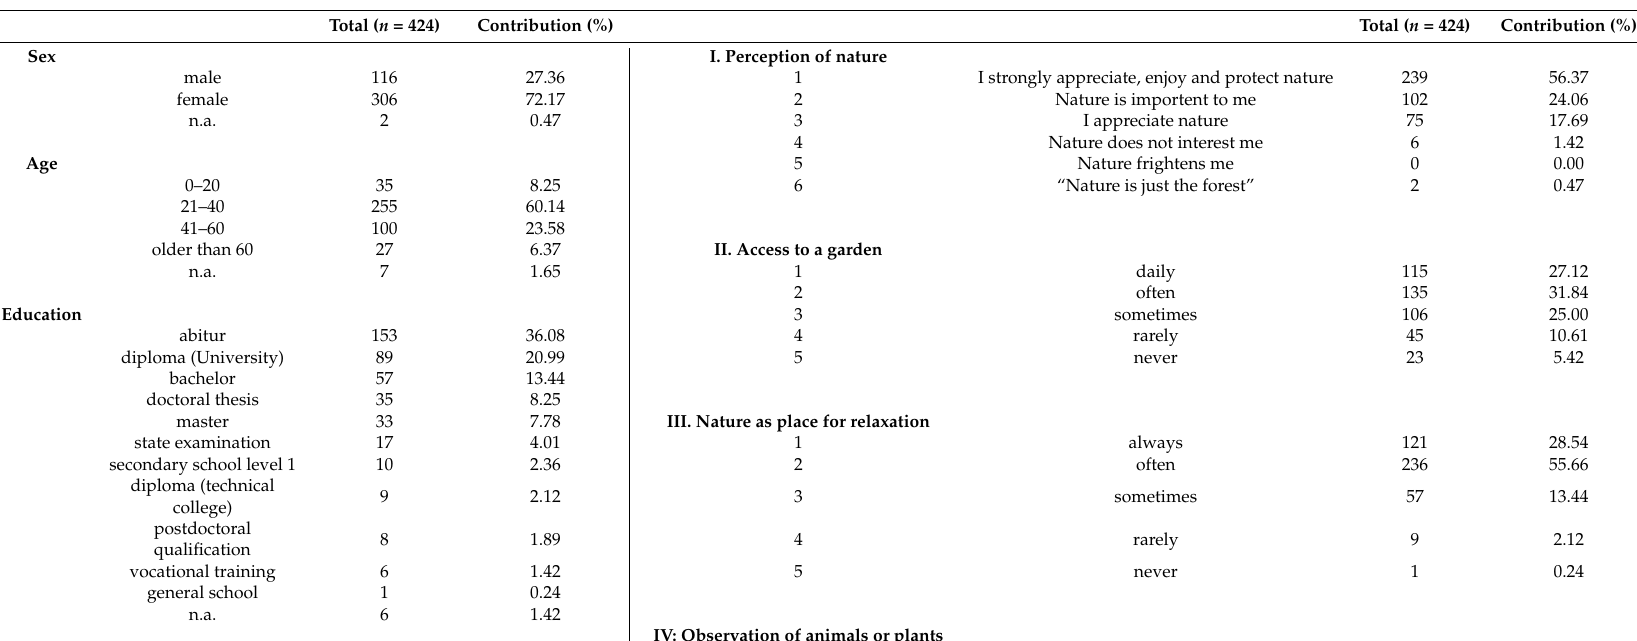
Table 1. Demographic composition of the 424 participants who answered the questionnaire including their attitudes towards nature. The results are given in both total numbers and